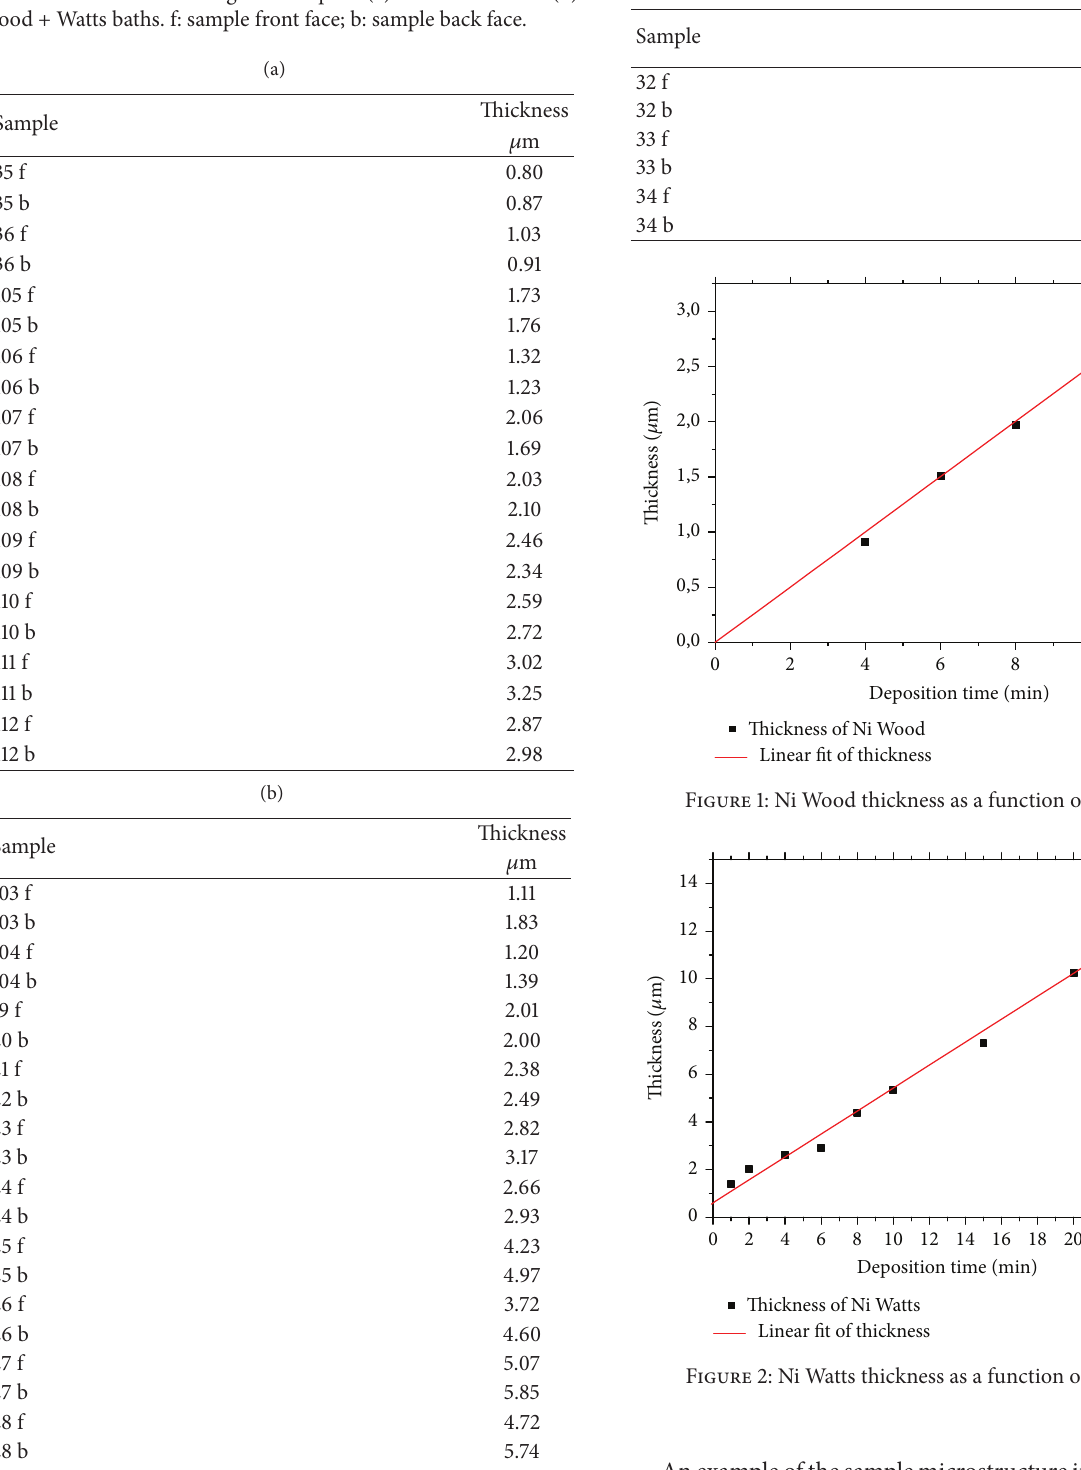
An example of the sample microstructure in the direction perpendicular to the sample surface is shown in Figure 4. Similar pictures, taken with both SEM and the optical micro- scope (for the Calotest method), have been used to obtain the Ni thickness by image analysis, as already described. The thickness values obtained with the two instruments are in fair